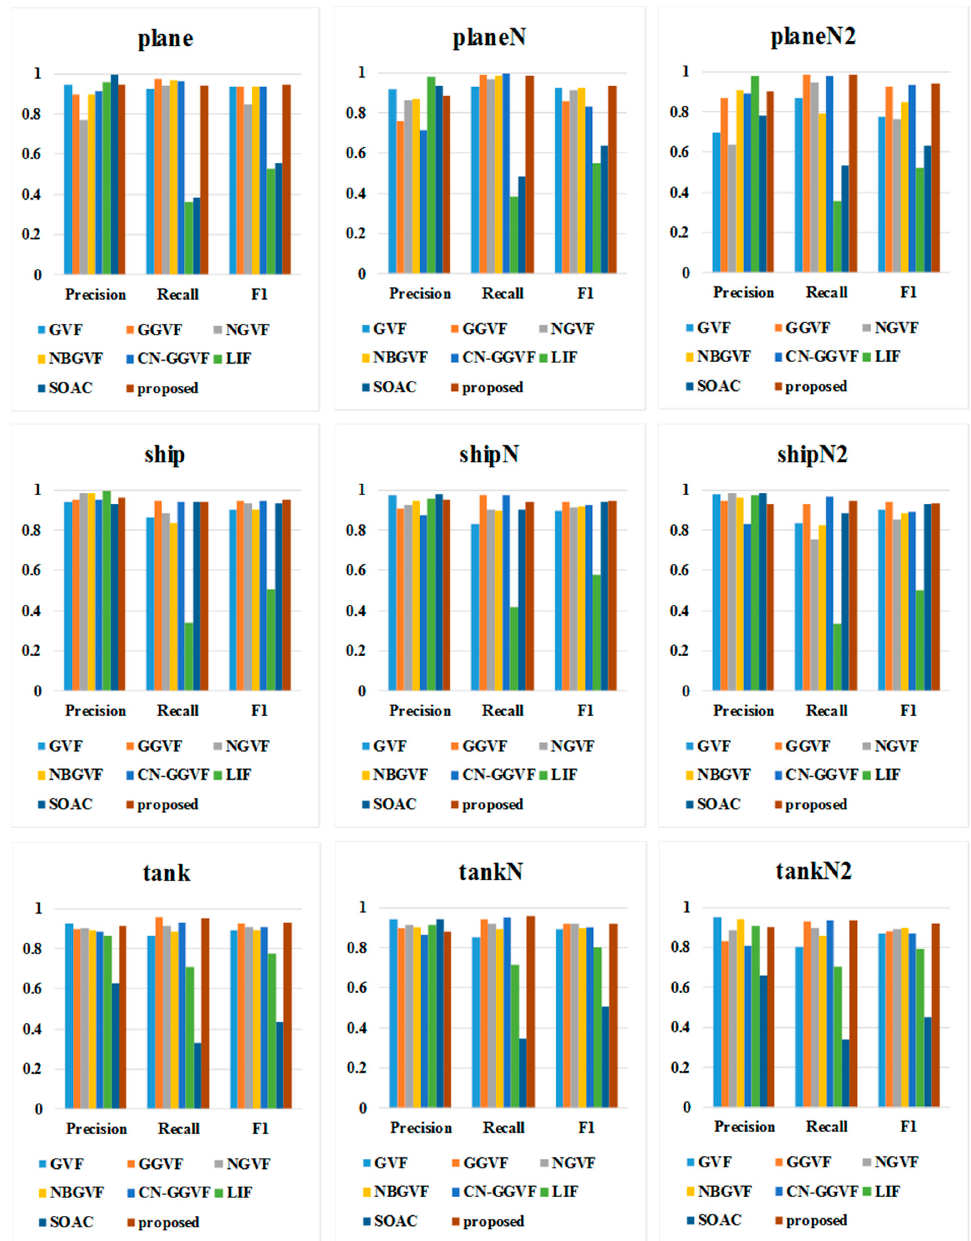
Figure 15. Block diagrams of quantitatively analyzed segmentation results of infrared images. Table 4. Average CPU time and number of iterations in the experiments of Sections 4.4 and 4.5.